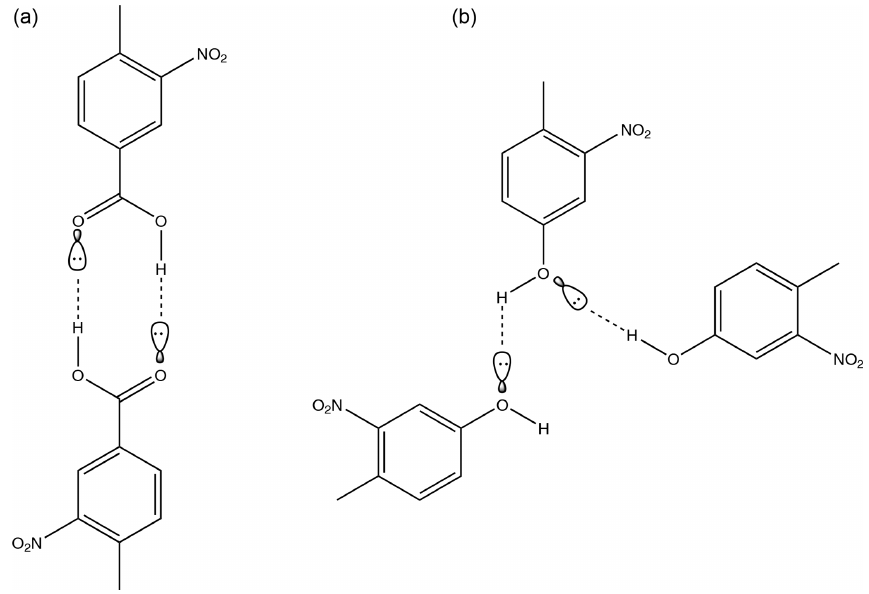
Figure 9. Diagram demonstrating how a carboxylic acid functionality allows a molecule to dimerise using H bonds in 4-methyl-3- nitrobenzoic acid (a) whilst a hydroxyl group only allows for hydrogen bonding to two other molecules with no opportunity to dimerise in 4-methyl-3-nitrophenol (b)